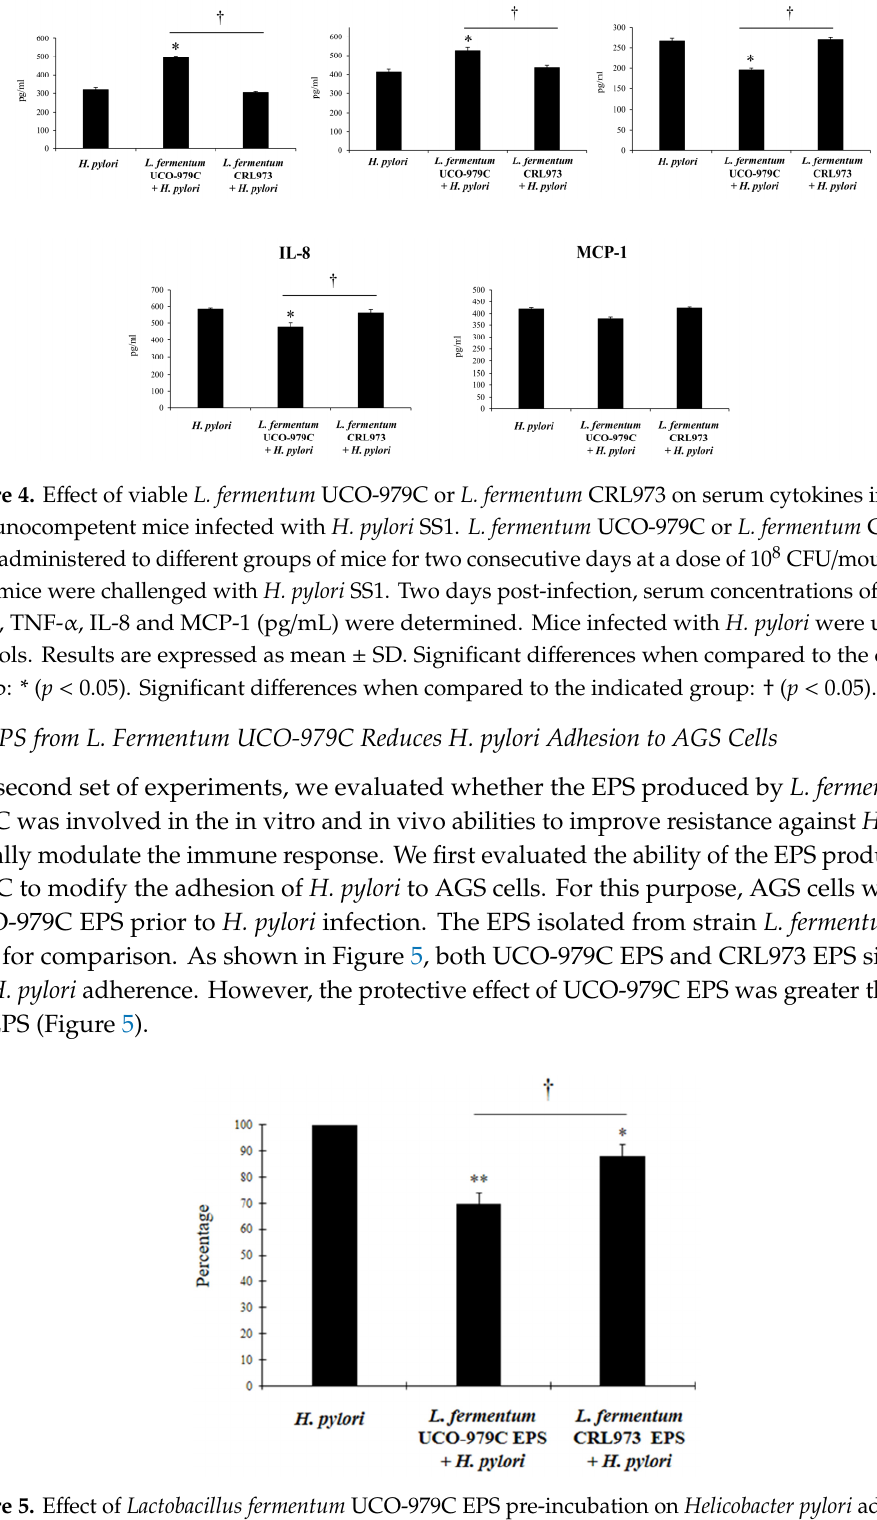
Figure 5. E ff ect of Lactobacillus fermentum UCO-979C EPS pre-incubation on Helicobacter pylori adhesion to human gastric epithelial cells (AGS cells) challenged with H. pylori. AGS cells were stimulated with EPS-979C or EPS-973 for 24 h before the challenge. Results are expressed in percentage, 100% correspond to infected control and represent data from three independent experiments. Results are expressed as mean ± SD. Significant differences when compared to the control group: * ( p < 0.05), ** ( p < 0.01). Significant differences when compared to the indicated group: † ( p < 0.05).